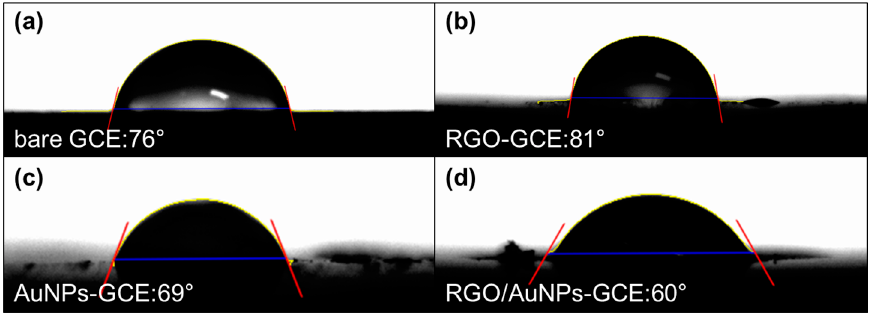
Figure 4. Contactangleanalysisof( a )bareGCE,( b )RGO-GCE,( c )AuNPs-GCE,and( d Figure 4. Contact angle analysis of ( a ) bare GCE, ( b ) RGO-GCE, ( c ) AuNPs-GCE, and ( d ) RGO/AuNPs-GCE.